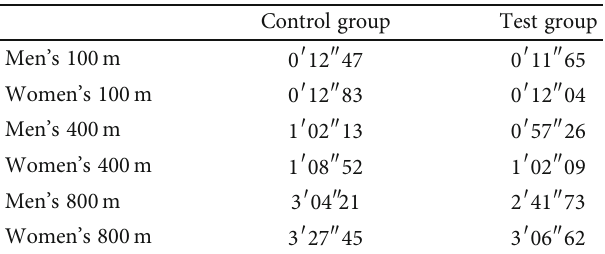
Figure 3: User login process of physical training teaching platform. Table 3: Comparative results of training for some track and fi eld